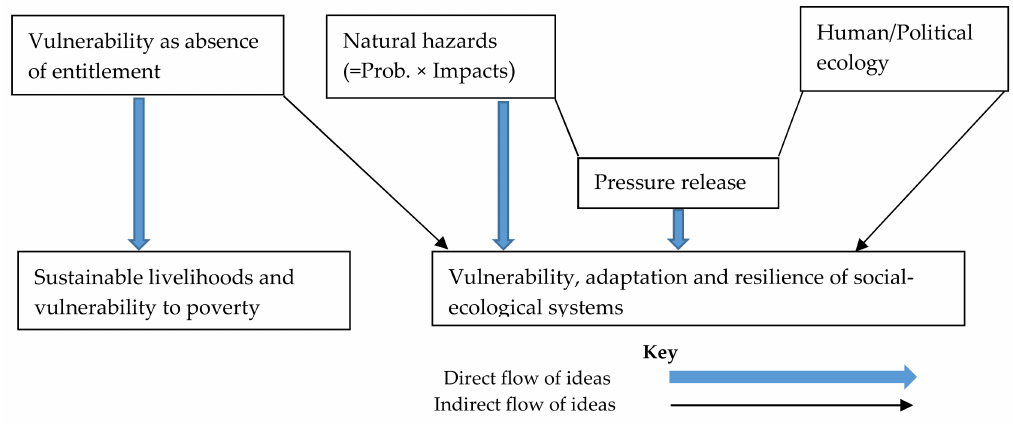
Figure 1. Sources of vulnerability and way to resilience. Source: Adapted from Adger